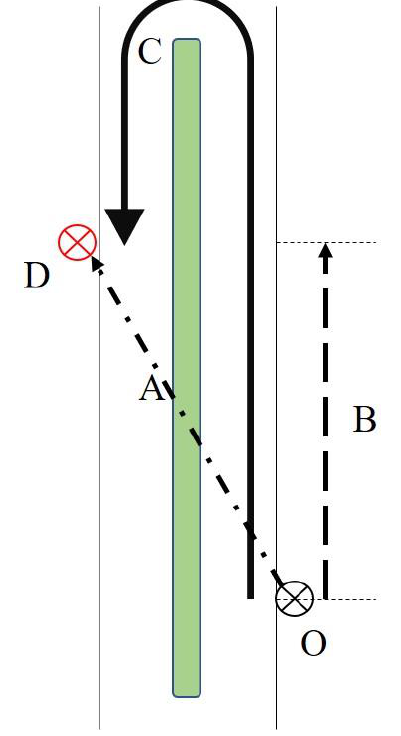
Figure 3 . Schematic diagram of three methods. Figure 4 . Distribution of travel factors